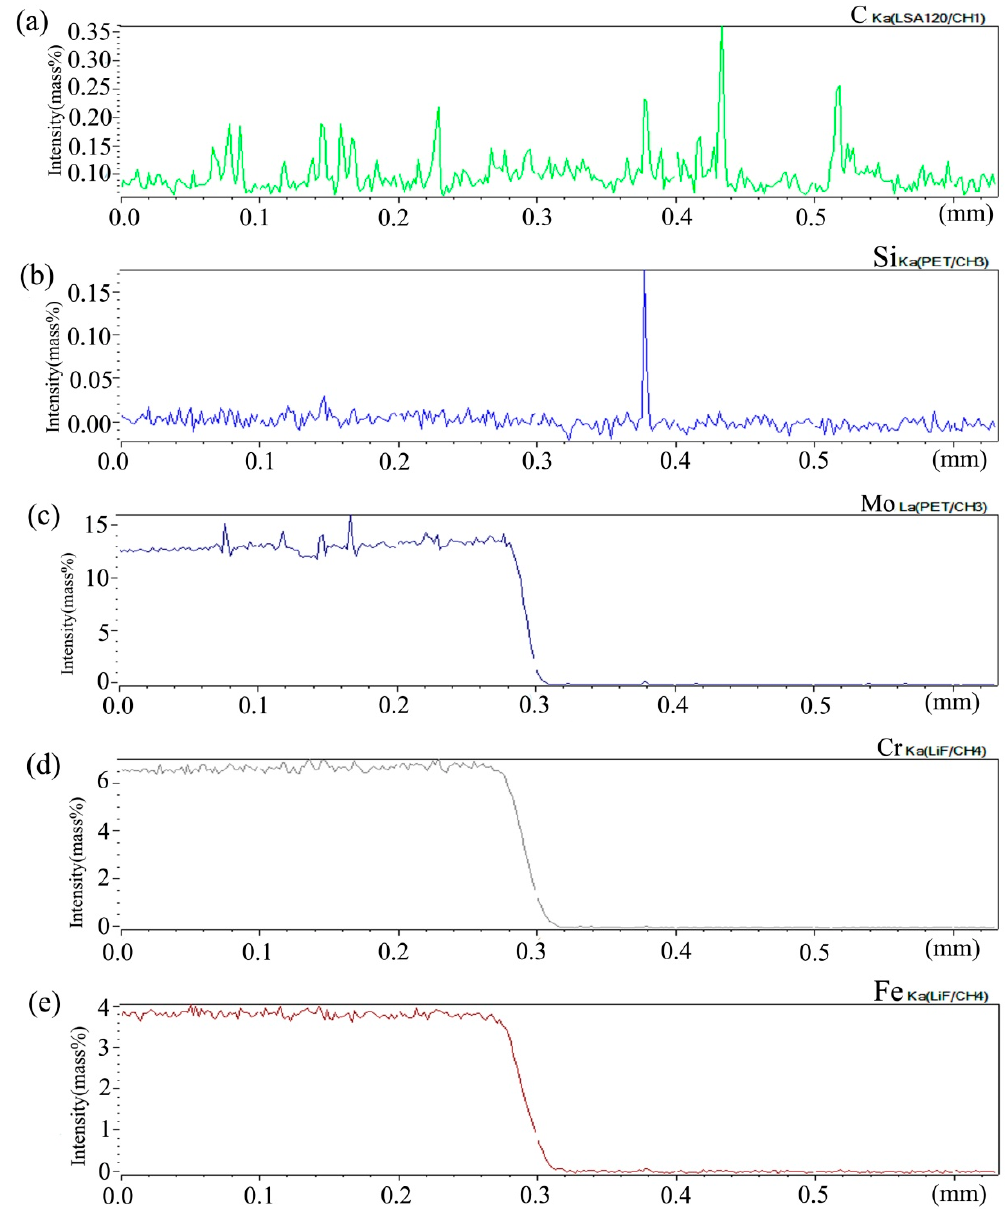
Figure 6. Composition distribution curve of the diffusion couple sample of 0Si alloy and pure nickel after 800 °C/200 h heat treatment: ( a ) C, ( b ) Si, ( c ) Mo, ( d ) Cr, and ( e ) Fe. (The horizontal coordinate of the figures is the scanning distance and the vertical coordinate is element signal intensity, the zero position is the starting point of scanning).